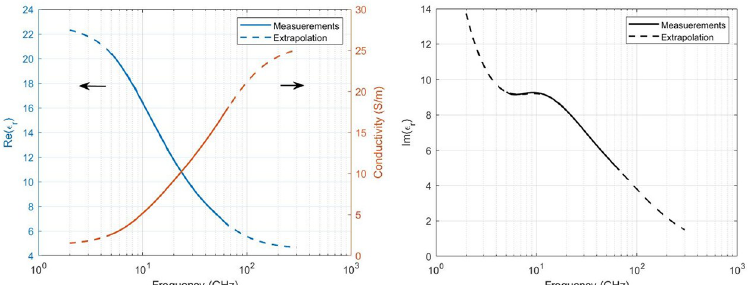
Fig 3. Dielectric parameters. Left: Measured (solid line) real part of the relative permittivity (blue) and conductivity (orange) and the extrapolation (dotted line). Right: Measured (solid line) imaginary part of the relative permittivity and the extrapolation (dotted line).